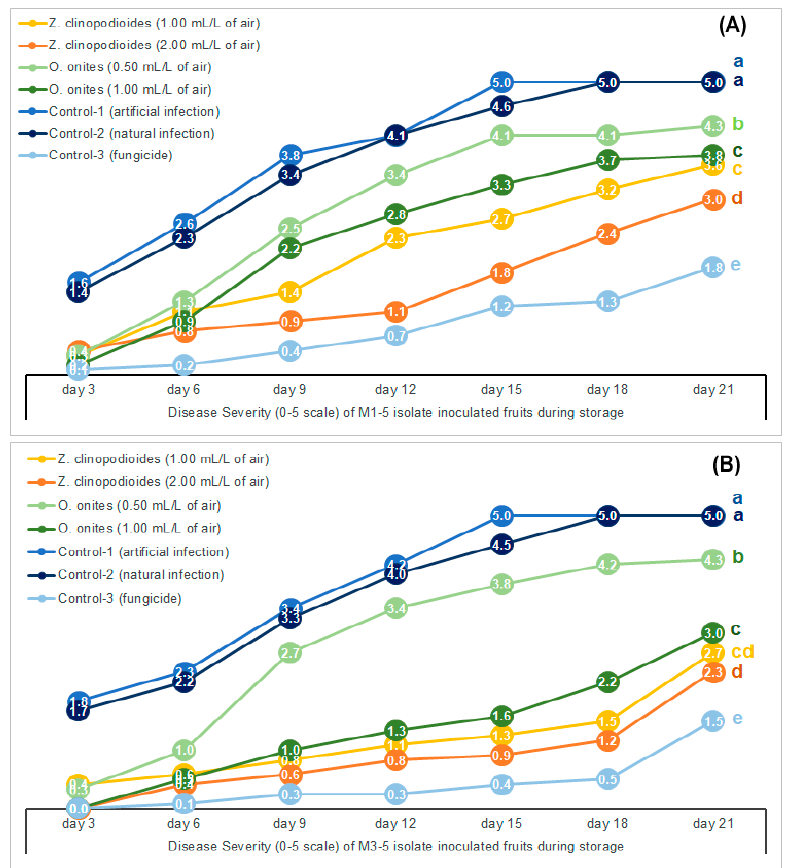
Figure 3. Vapor contact impacts of O. onites and Z. clinopodioides essential oils on the disease severity (0–5 scale) of ( A ) M1-5 and ( B ) M3-5 isolates of B. cinerea inoculated on strawberry fruits during 21 days of storage. Different letters next to the lines of each treatment represents significant difference at the 21st day of storage, according to Tukey’s HSD test ( p ≤